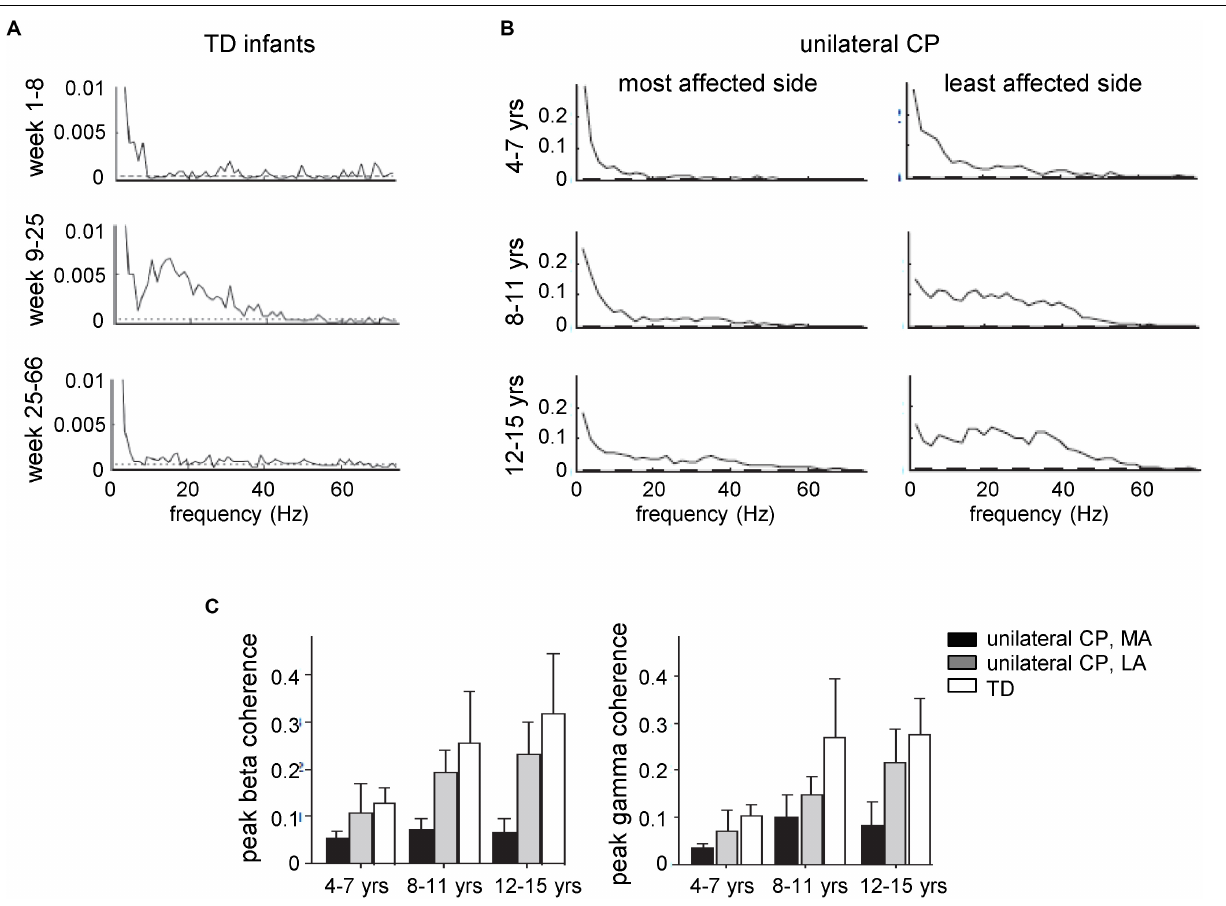
FIGURE 2 | Development of central common drive to a leg muscle. EMG traces were obtained from electrodes placed at the proximal and distal part of the tibialis anterior muscle. Coherence estimates provide a measure of the fraction of the activity in one surface EMG signal at any given frequency that can be predicted by the activity in the second surface EMG signal, reflecting the strength of common rhythmic synaptic inputs distributed across the motoneuron pool. (A) EMG–EMG pooled coherence at different frequencies for the three age groups given by the corrected age: 1–8, 9–25, and 25–66 weeks. The dashed lines indicate the 95% confidence levels for the pooled data (adapted from Ritterband-Rosenbaum et al., 2017 with permission). (B) Pooled estimates of coherence from all subjects with unilateral CP for the most and least affected sides for three different age groups: 4–7, 8–11, and 12–15 years. (C) Peak beta-band and gamma-band coherences in CP (MA, most affected; LA, least affected side) and TD children across the three different age groups. Error bars denote 95% confidence intervals [panels (B,C) adapted from Petersen et al., 2013 with